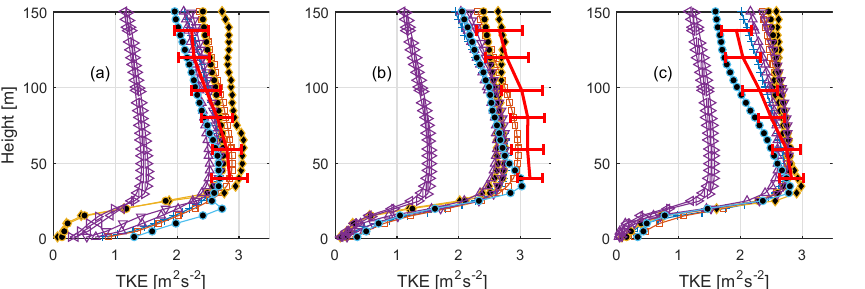
Figure 6. TKE profiles. The red full line shows the average from the sonics. Error bars indicate the 95% confidence level for the mean value. The various other markers indicate simulated TKE levels. Please see Table 1 for a legend of the marker representations. LES models have been given black filling in order to increase readability. (a) Results from 100 ◦ , (b) from 240 ◦ , and (c) from 290 ◦